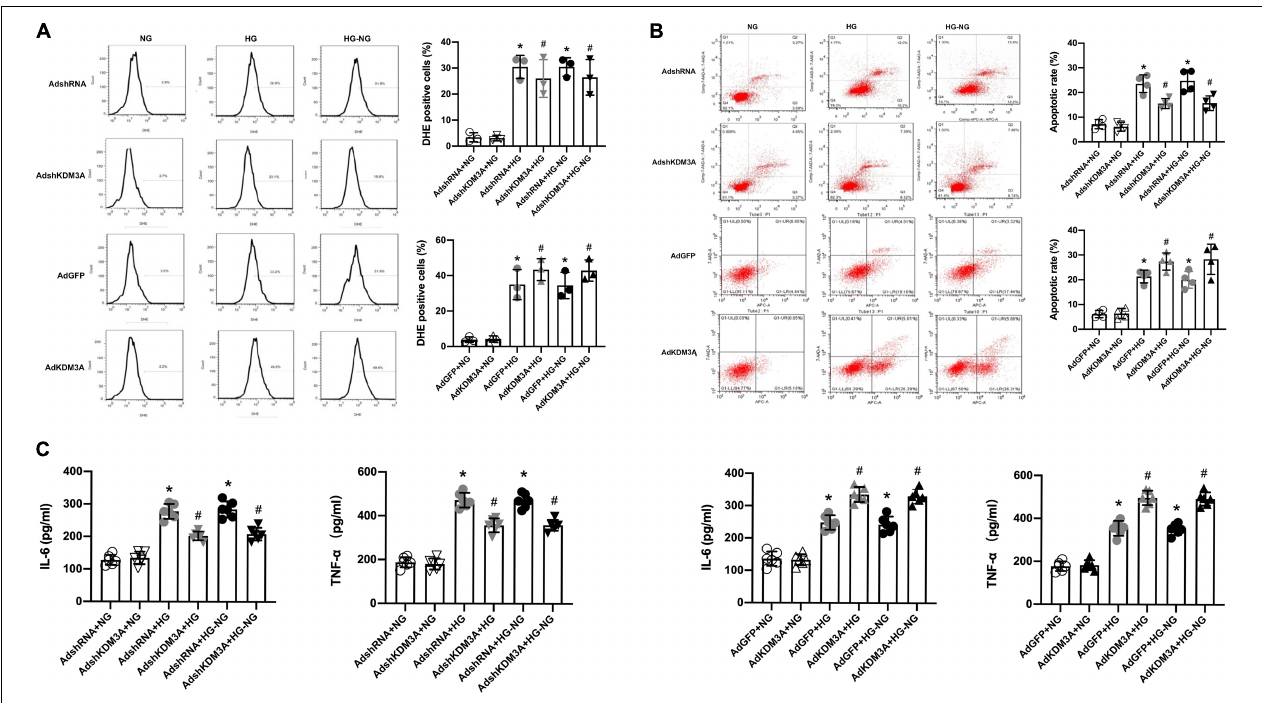
FIGURE 2 | KDM3A knock-down could exacerbate while KDM3A over-expression could ameliorate continuous cardiomyocytes dysfunction induced by high glucose. (A) The ROS production was evaluated by DHE and flow cytometry, and the percentage of DHE positive cells in different groups were calculated ( n = 3). (B) Flow cytometry was used to detect the apoptosis of cardiomyocytes, and the apoptotic rate of each group was quantitatively analyzed ( n = 4). (C) To investigate the effects of KDM3A on inflammation under hyperglycemia stimulation, IL-6 and TNF- α in myocardial cells were measured using an ELISA kit ( n = 4). * p < 0.05, as compared to the AdshRNA + NG or AdGFP + NG; # p < 0.05, as compared to the AdshRNA + HG or AdshRNA + HG–NG, AdGFP + HG or AdGFP +